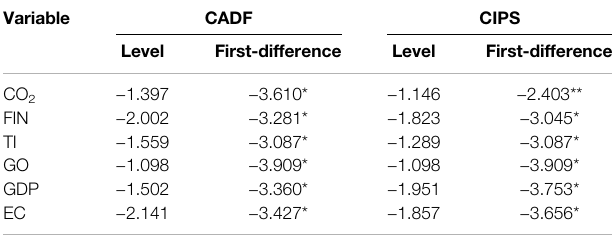
TABLE 4 | Panel unit root test results.